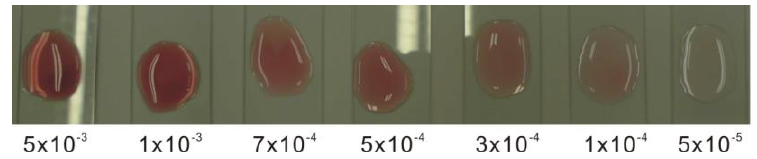
Figure 8. Qualitative analysis of the proposed sensor. The H 2 O 2 concentration varied from 5 × 10 −5 % to 5 × 10 − 3 % with the POD concentration controlled at 0.001 mg/mL.